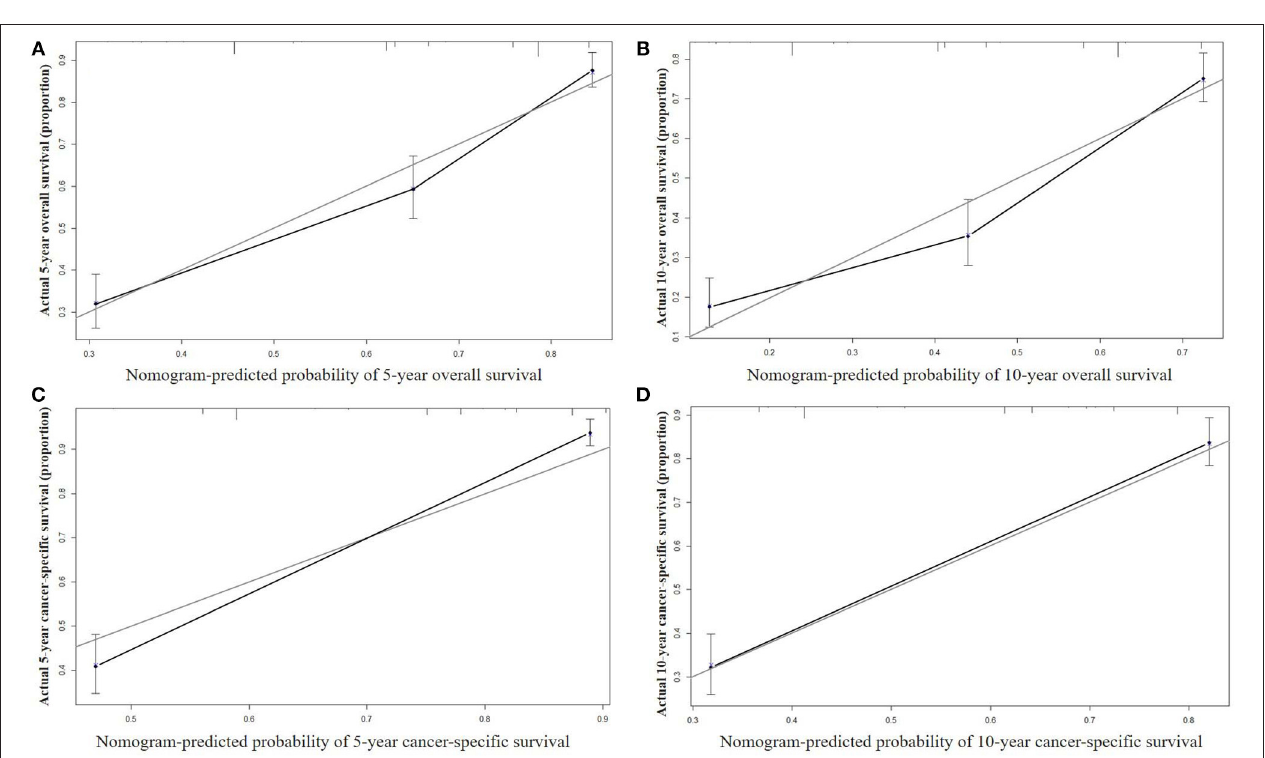
FIGURE 3 | Internal calibration curves for 5-year (A) and 10-year (B) overall survival; and 5-year (C) and 10-year (D) cancer-specific survival. The X axis represents the nomogram predicted survival rate, whereas the Y axis represents the actual survival rate.